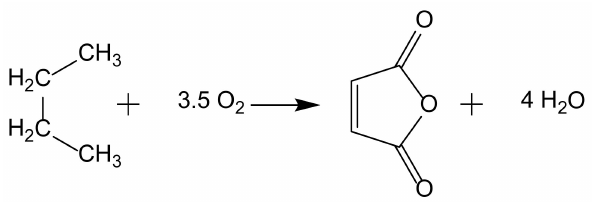
Figure 1. Maleic anhydride synthesis from n -butane oxidation.